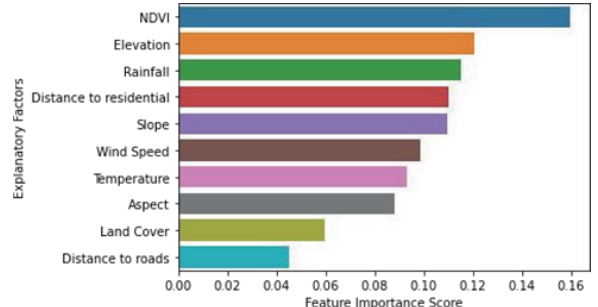
Figure. 8. The feature importance factors.